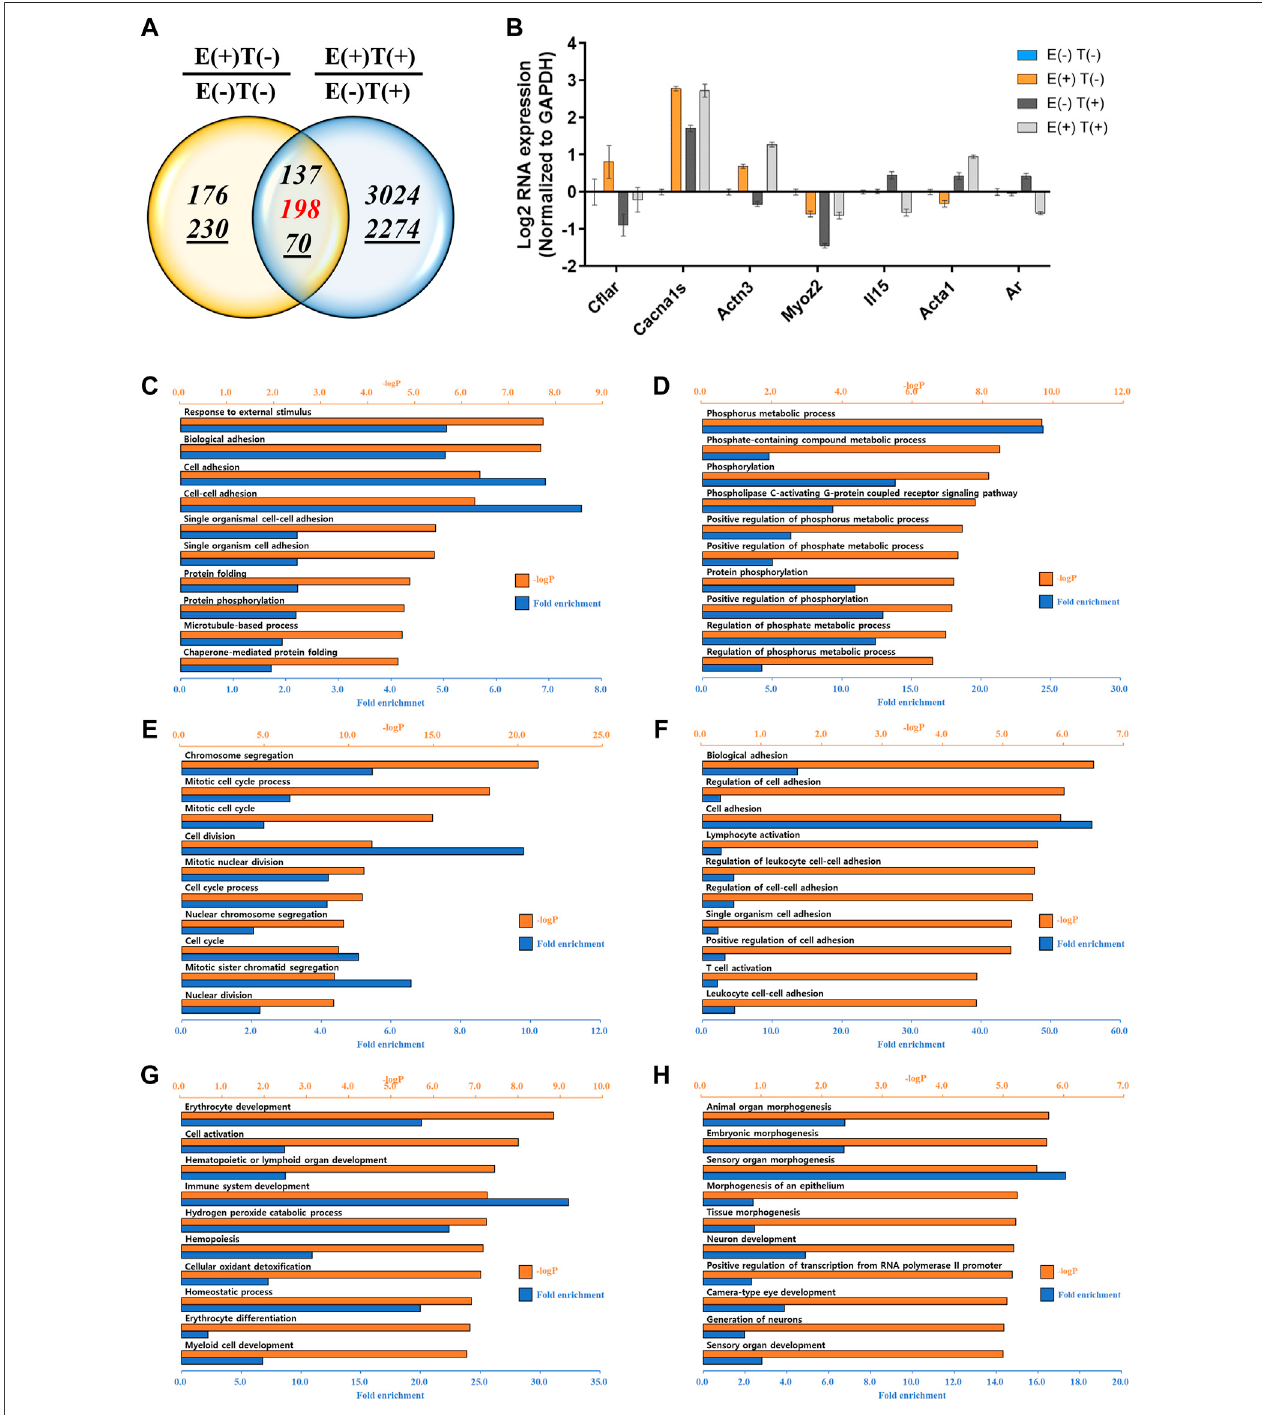
FIGURE 4 | mRNA-seq analysis of the lungs. (A) Venn diagram of the number of DEGs for the effect of exercise for normal [E(+)T( − )/E( − )T( − )] and tumor-bearing [E(+)T(+)/E( − )T(+)] mice. The italicized number indicates the number of upregulated genes while the italicized and underlined number indicates the number of downregulated genes. Thosewith opposite effects between thetwogroups (contra-regulated) are shown inred. The DEGswerede fi ned asgeneswith afoldchangeof two and a normalized read count of four. (B) Bar graph of log2 fold change of selected genes in the contra-regulated group using RT-qPCR of the littermates. The foldchangewascalculatedbynormalizingthedatatothatof GAPDH andthentothelevelinthenormalcontrolgroup.Aconsistentchangecompared tothemRNA-seq analysiswasobserved. (C,D) GOanalysisoftheupregulated (C) ordownregulatedDEGs (D) comparing E(+)T( − )and E( − )T( − )mice.Signi fi cantlyenriched termsinclude cell adhesion, protein folding,and phosphorusmetabolic process. (E,F) GO analysisoftheupregulated (E) or downregulatedDEGs (F) comparing E( − )T(+) and E( − )T( − )